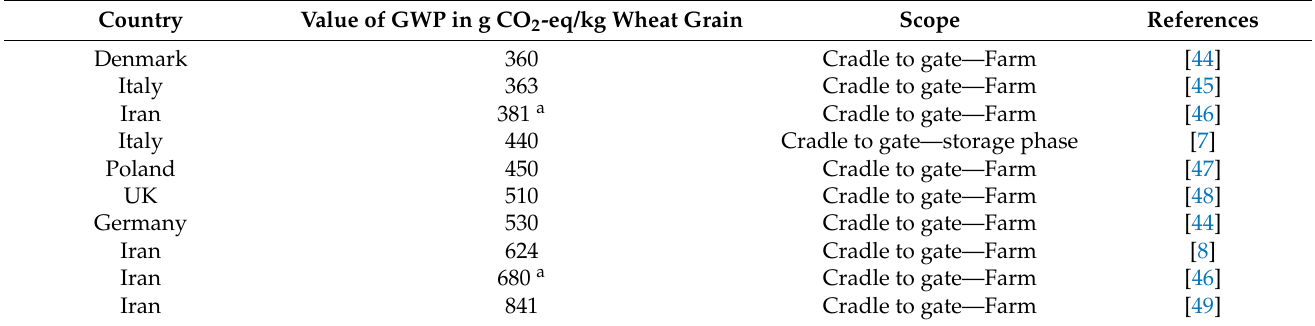
Table 2. Values of carbon footprints reported for wheat grain in earlier